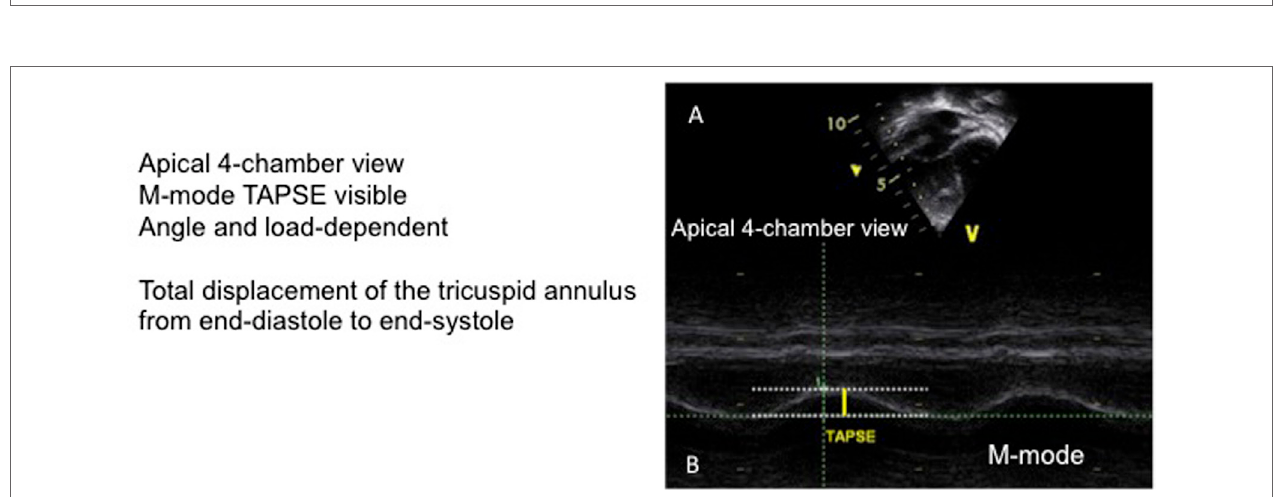
FigURe 6 | Measurement of the right ventricular fractional area change (RVFAC). (A) Four-chamber view allowing measurement of the surface of the right ventricle (RV) in systole (RVESA). (b) Four-chamber view allowing for the measurement of the surface of the RV in diastole (RVEDA).